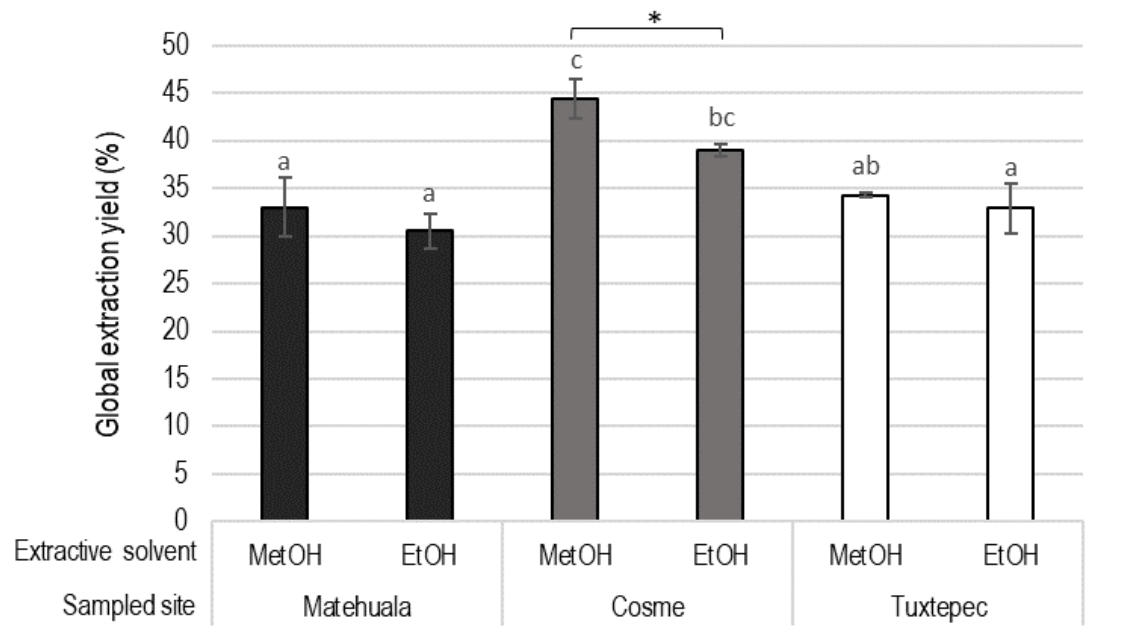
Figure 3. Extraction yields in percentage of dry biomass (%) obtained for methanolic (MetOH) and ethanolic (EtOH) extraction of Agave lechuguilla by-product from three different geographical sites. The letters show statistical significance between extracts (one-way ANOVA and Tukey post-hoc results, n = 3, p- value < 0.05), and * indicates solvent effect (two-way ANOVA, n = 3, p- value < 0.01).